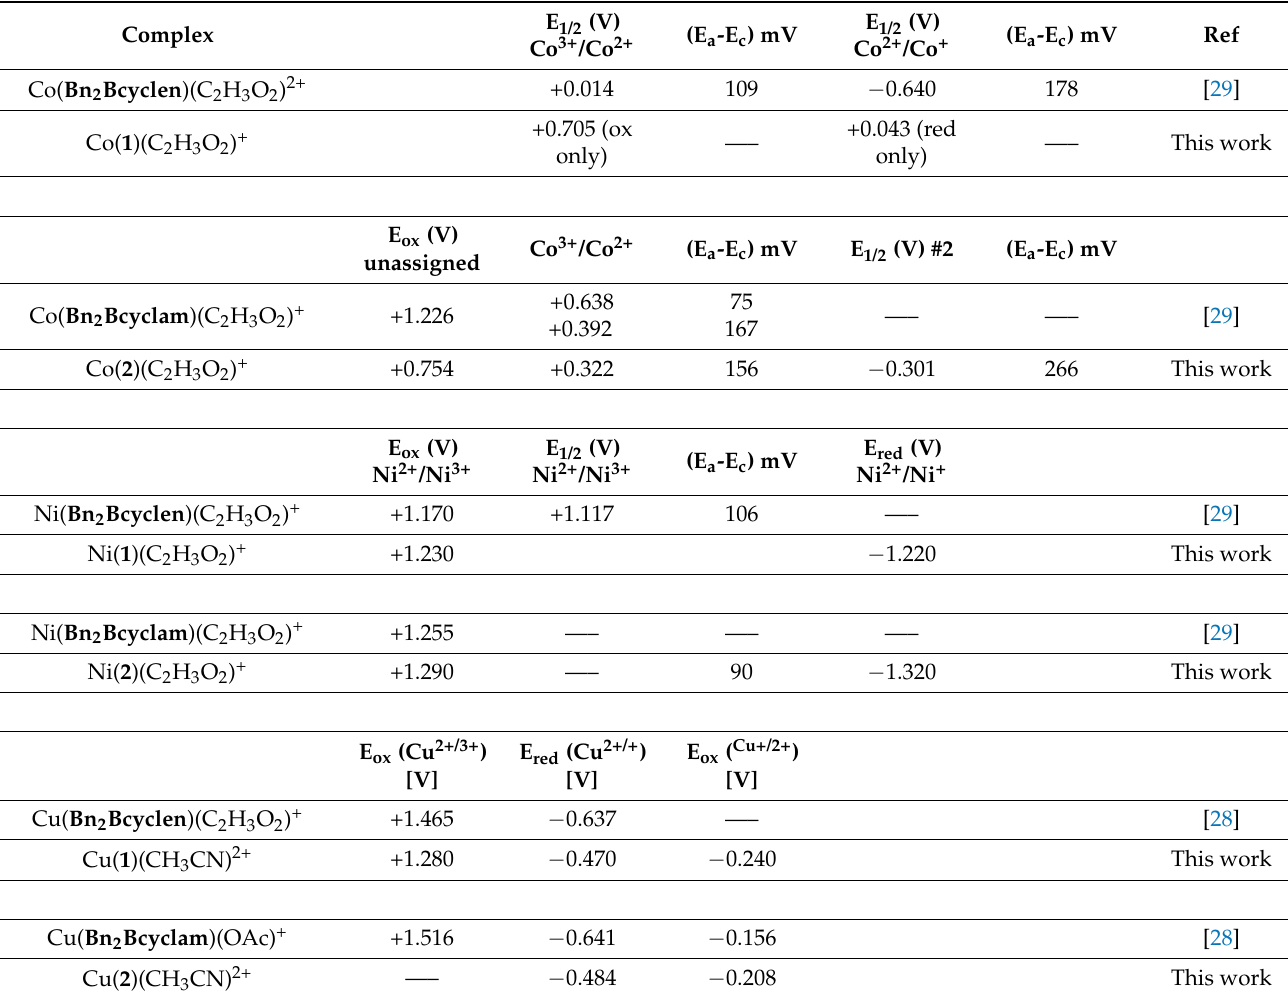
Table 6. Redox potentials (vs. SHE) with peak